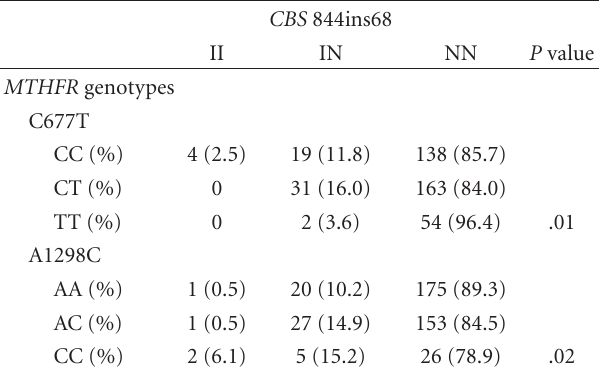
Table 4: Maternal MTHFR and CBS 844ins68 genotype combina- tions, Children’s Hospital of Philadelphia, 1997–2007.